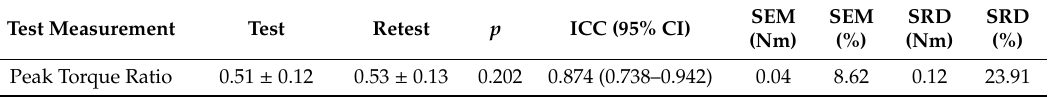
Table 4. Summary and reliability of isokinetic peak torque ratio at 60°/s on two occasions ( n = 25).